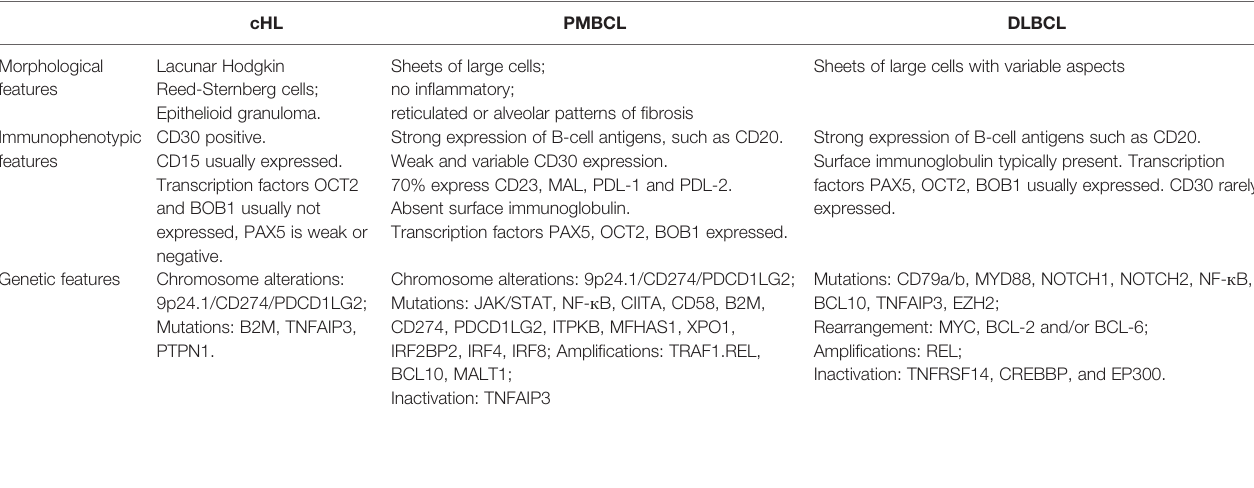
TABLE 1 | Comparison of PMBCL with other mediastinal lymphoma diseases in pathological